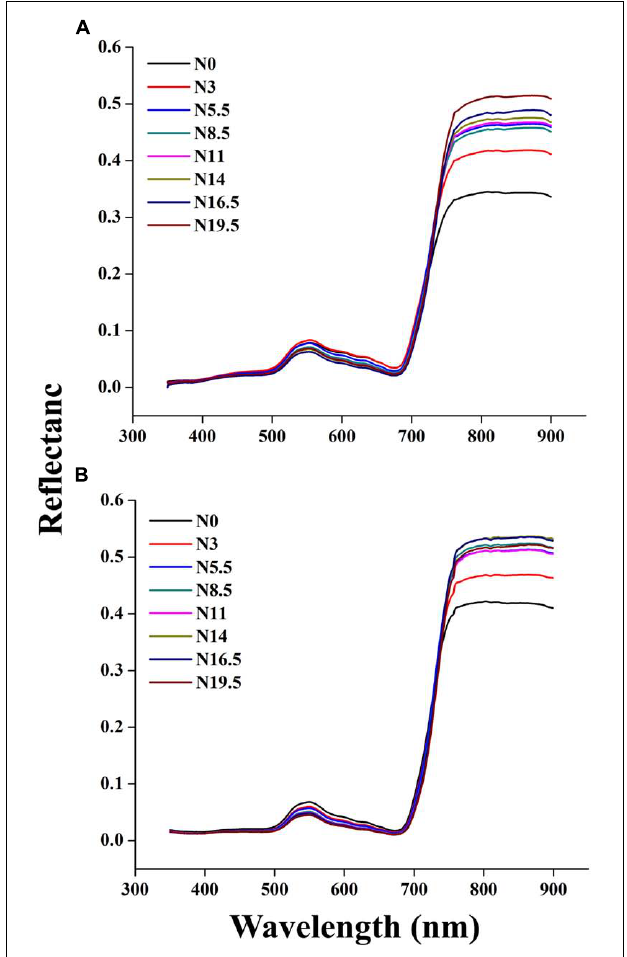
FIGURE 3 | Change in canopy reflectance spectra under different N rates at critical growth stages of rice in 2015 (A) 2016 (B) , where N0, N3, N5.5, N8.5, N11, N14, N16.5, and N19.5 represents 0, 45, 83, 128, 165, 210, 248, and 293 kg N ha − 1 , respectively.